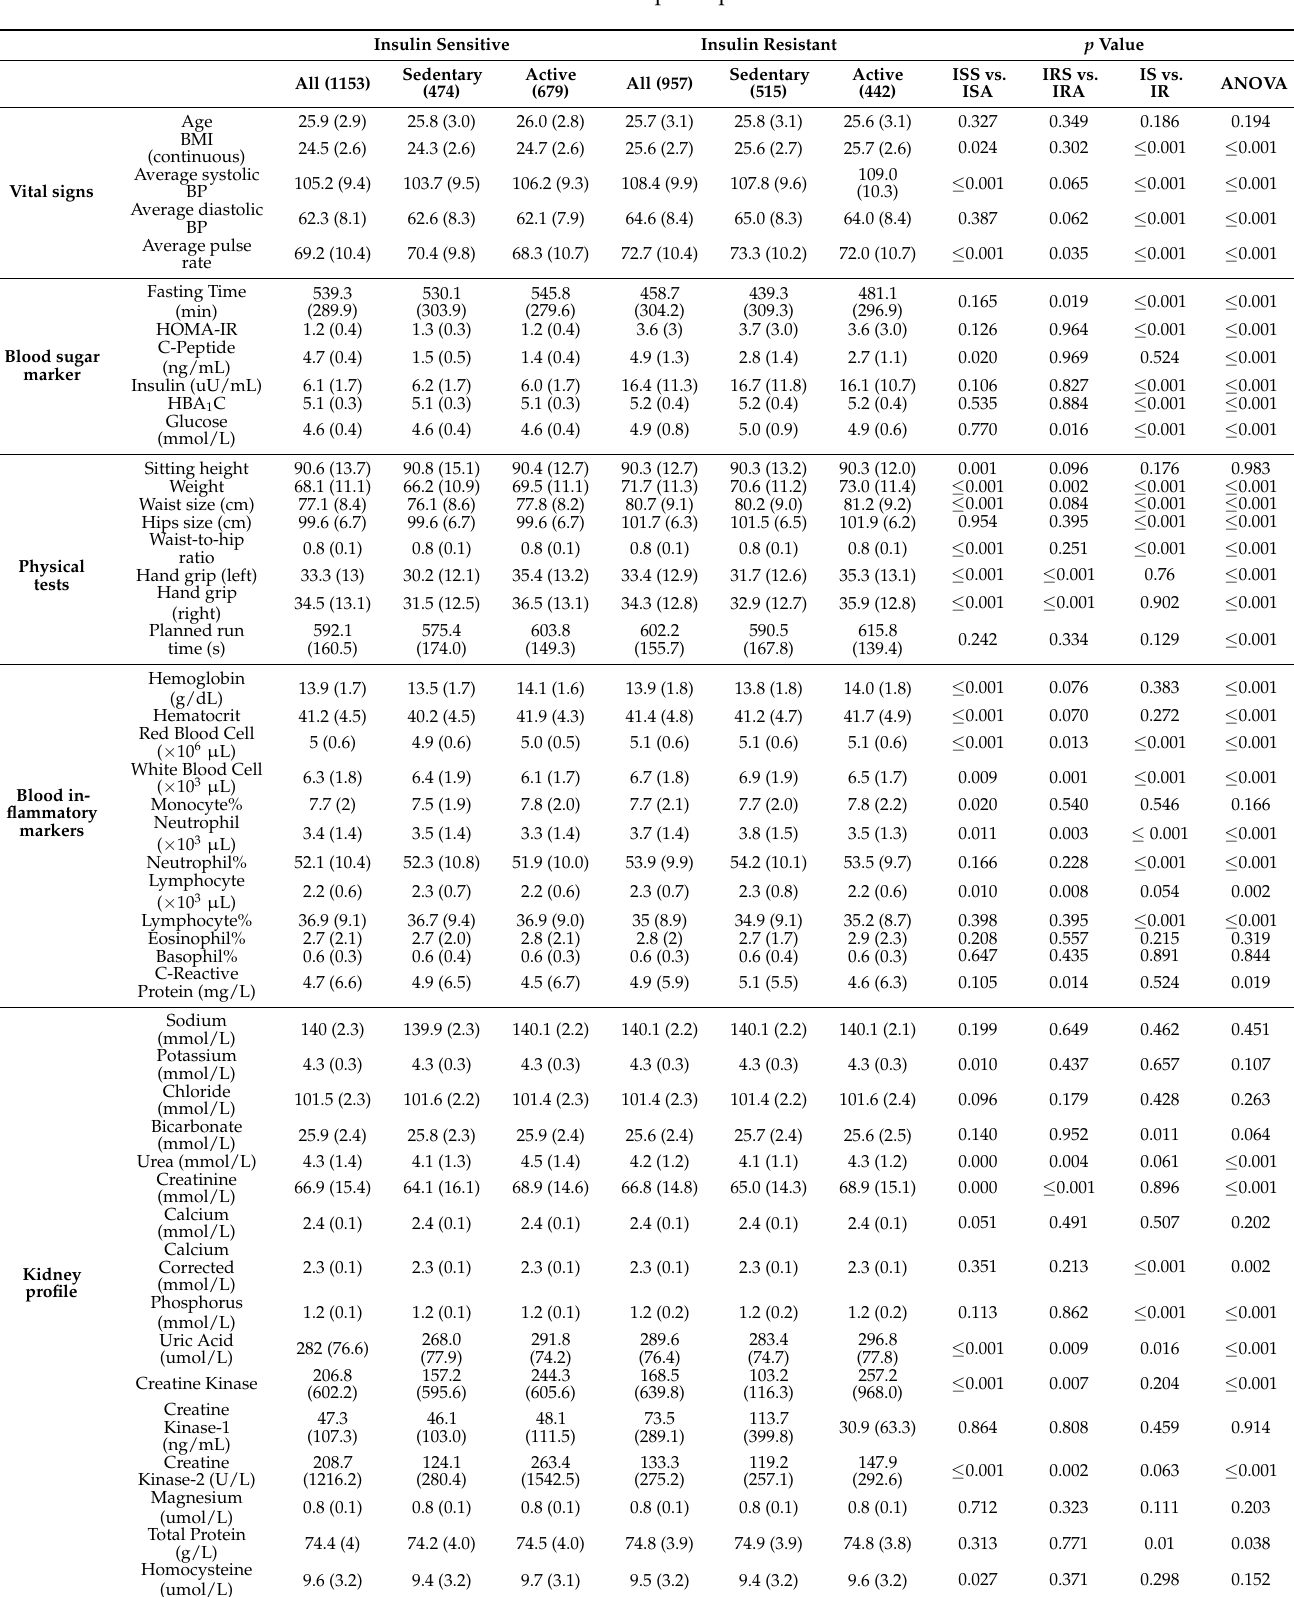
Table 1. General characteristics of